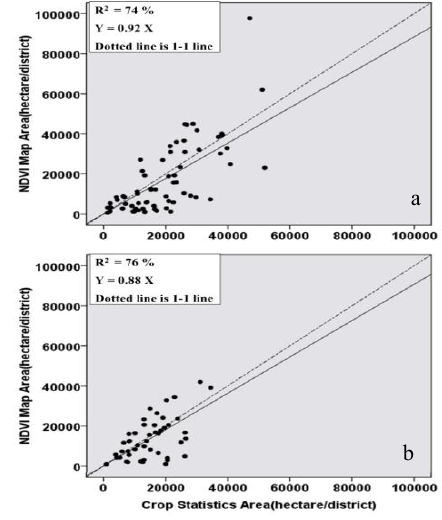
Figure 8. Scatter plots showing, two rice crop (a) and three rice crop (b) land use systems of the NDVI rice unit map versus crop statistics.